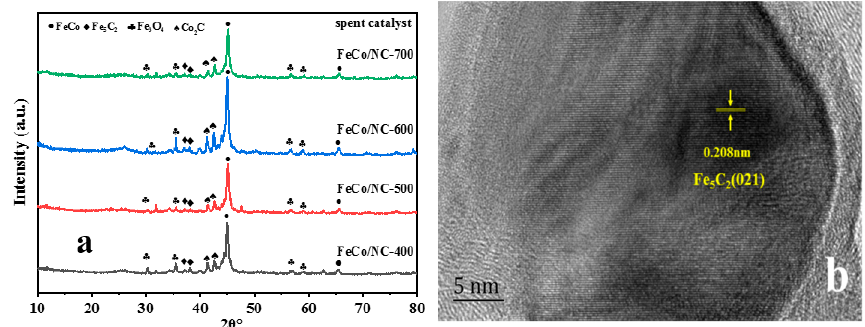
Figure 10. ( a ) XRD of spent FeCo/NC-T catalysts and ( b ) HR-TEM images of spent FeCo/NC-600.